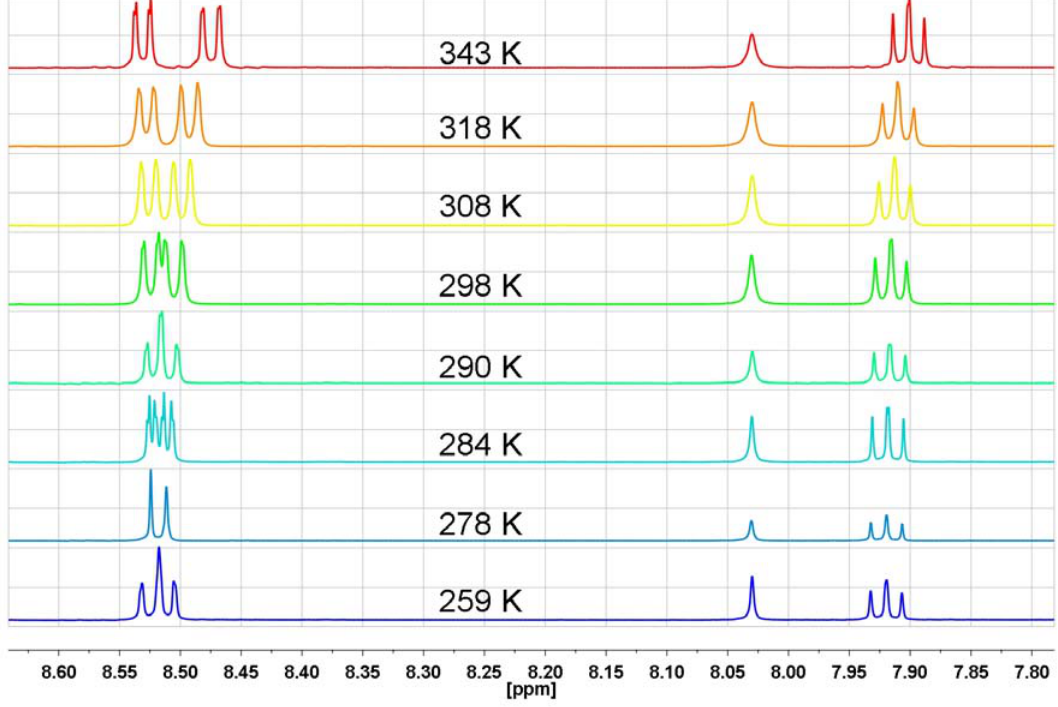
Figure 11. The range of aromatic protons of 1 H-NMR spectrum in DMF-d 1,8-naphthalimide at different